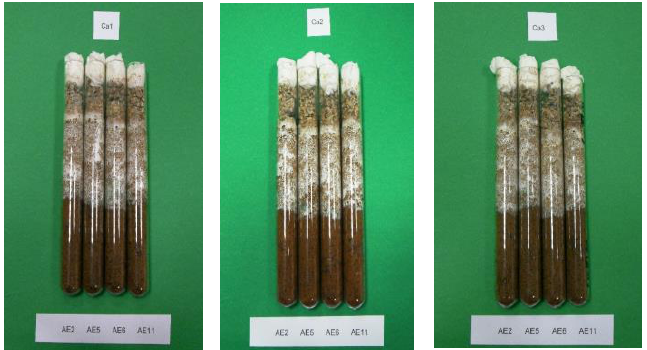
Figure 2. Comparison of the growth of mycelium of A. cylindracea on substrates with addition of CaCO 3 at three doses (Ca1 – 2 g; Ca2 – 4 g; Ca3 – 8 g/100 g of DM